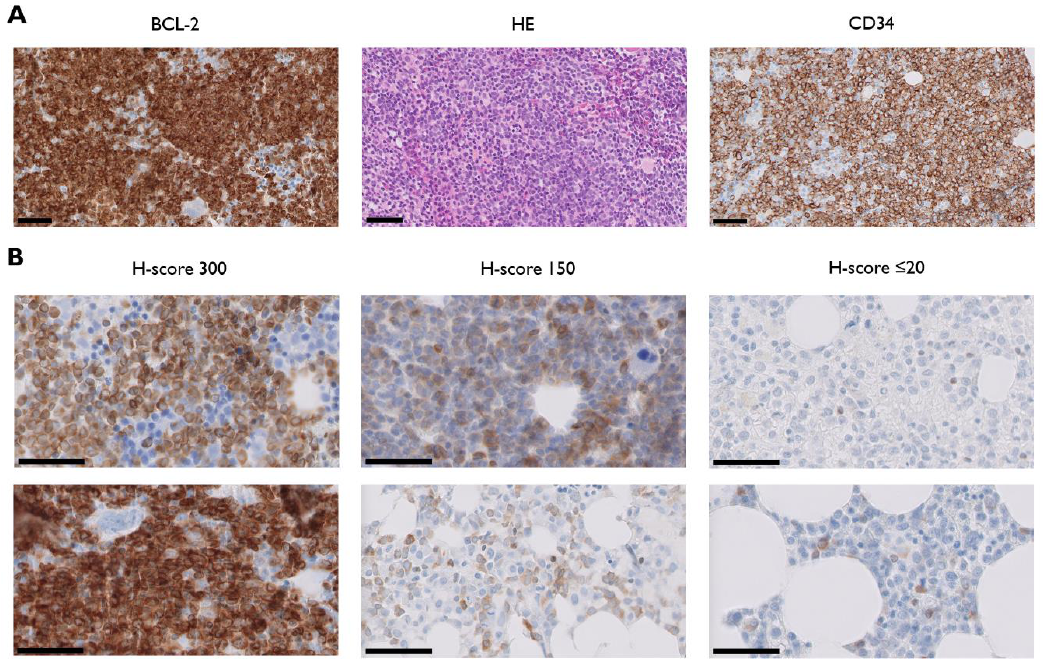
Figure 1. ( A ) Light micrographs of BCL-2 (B-cell leukemia/lymphoma-2, left) and corresponding haematoxylin and eosin (HE; middle) and CD34 stained paraffin sections of trephine biopsies from one representative acute myeloid leukemia patient with a BCL-2 H-score of 300; ( B ) bone marrow BCL-2 immunostains from two representative patients with H-scores of 300 (left panel), 150 (middle panel), and ≤20 (right panel). Thick black line = 50 µm.